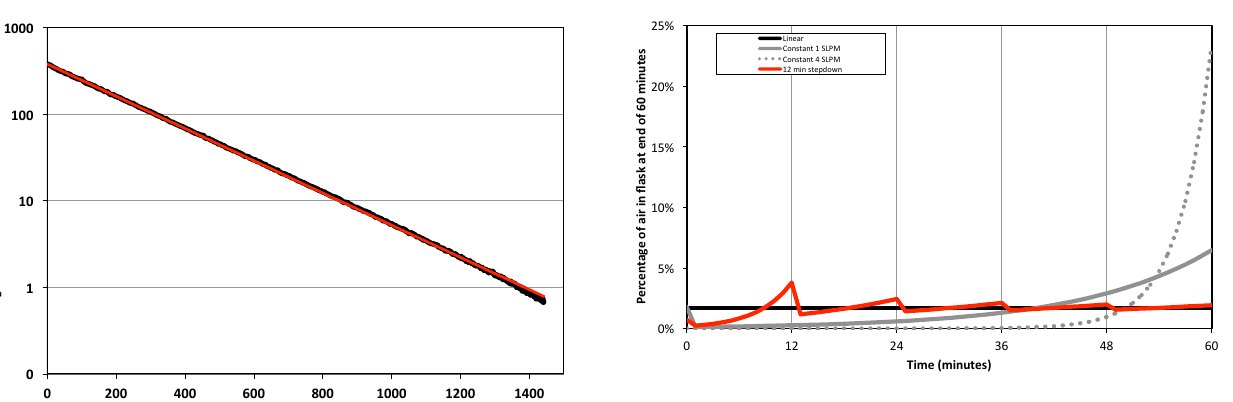
Fig. 3. Weighting function for air inside the 15l integrating vol- ume after 60min, under different flow scenarios. Black line: ideal linear weighting function where each timestep contributes an equal amount to the final sample (1.67% from each minute). Solid and dotted grey lines: constant flow at 1 and 4SLPM, respectively. Red line: the weighting function we selected changing the flow rate ev- ery 12min from 3.8SLPM to 1SLPM to 0.55SLPM to 0.38SLPM to 0.29SLPM. The value at minute zero for each curve is the sum total of all air remaining in the flask from times prior to the last